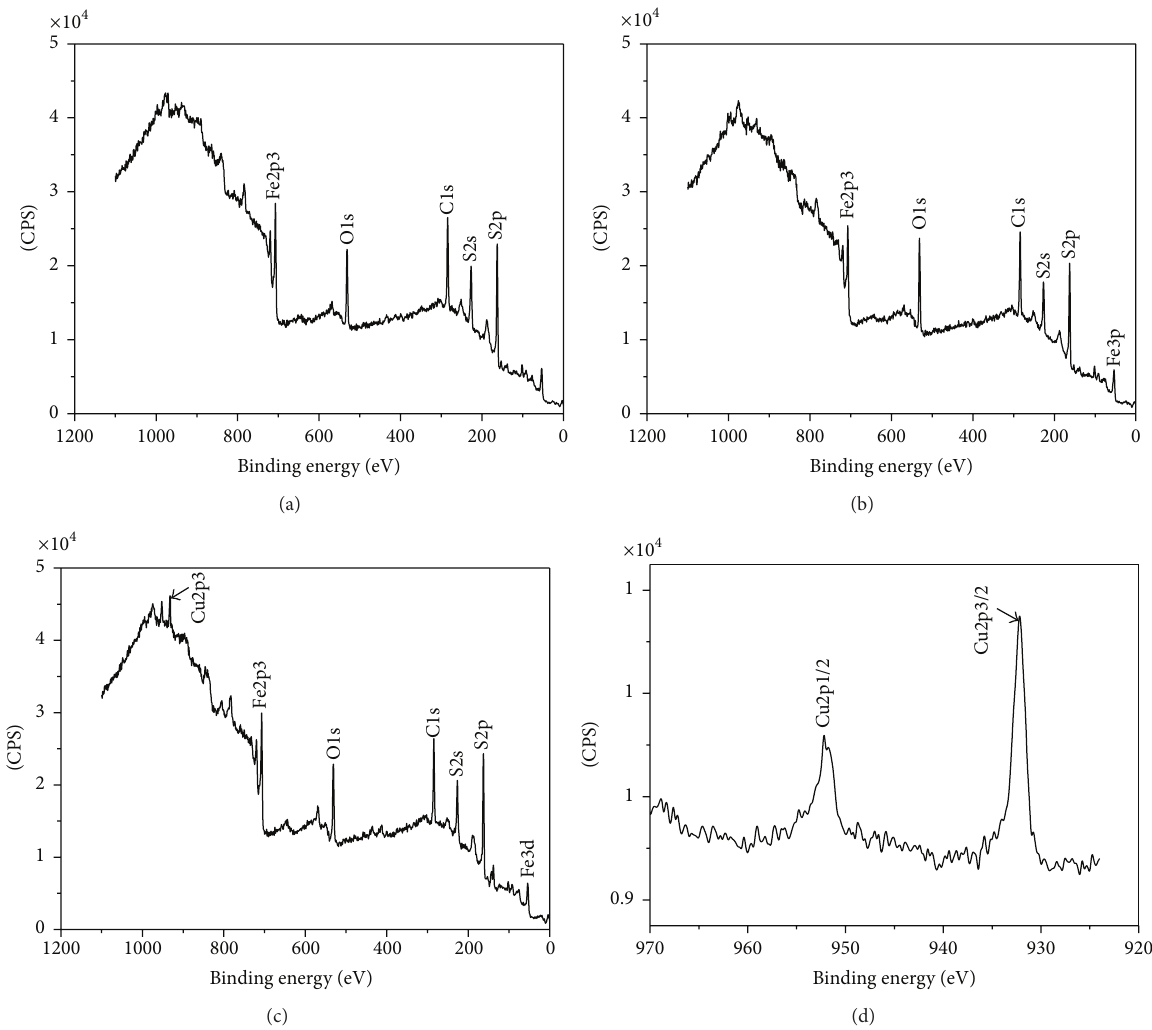
Figure 7: XPS spectra of pyrite conditioned with CuSO 4 at different pH. (a) pH = 4, (b) pH = 7.3, and (c) pH = 10. (d) Cu2p spectra of pyrite conditioned with copper sulfate at pH =